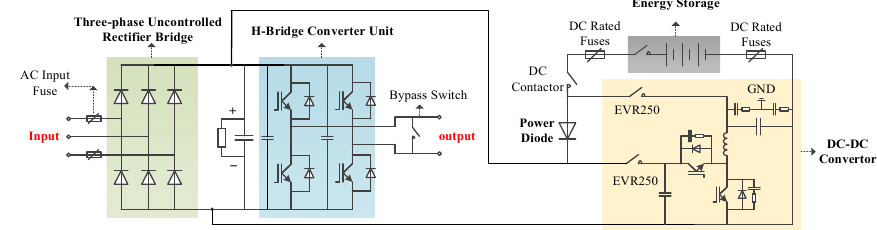
Figure 2. Topology diagram of the cascade power unit.